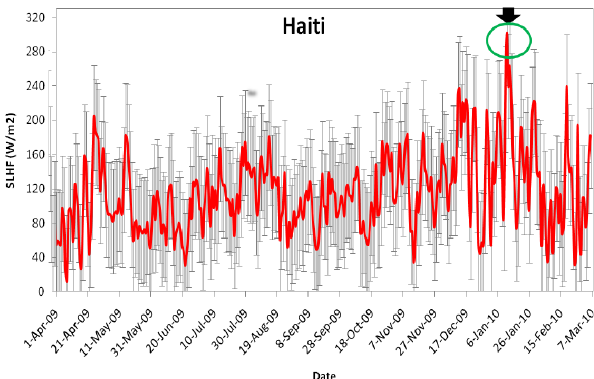
Fig. 4a. Figure 4a shows variation of daily surface latent heat flux. A maxima peak in surface latent heat flux is observed one day prior to the main earthquake event, error bars shows one standard deviation.